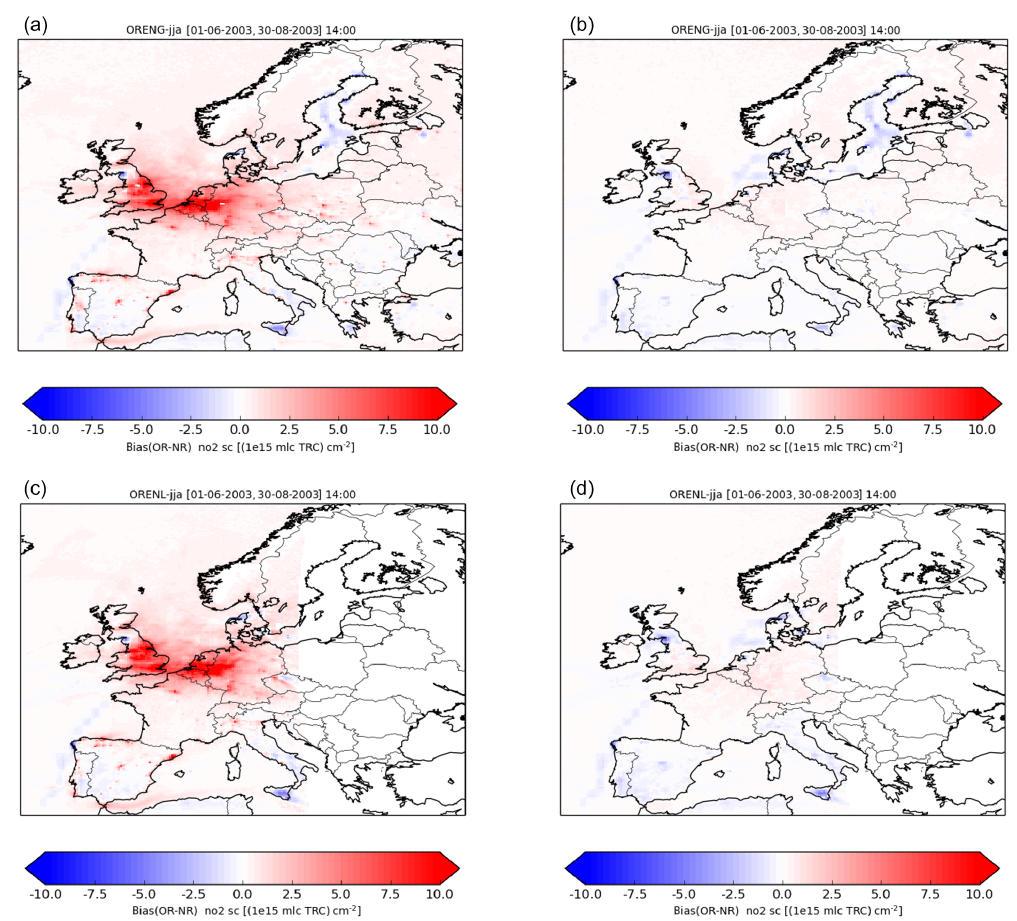
Figure 10. Summer period (JJA 2003) average NO 2 column bias at 14:00UTC, with synthetic observations for the control run without assimilation (a, c) and with assimilation (b, d) of ground-based O 3 + S4 NO 2 (b) and ground-based O 3 + S5P NO 2 (d)